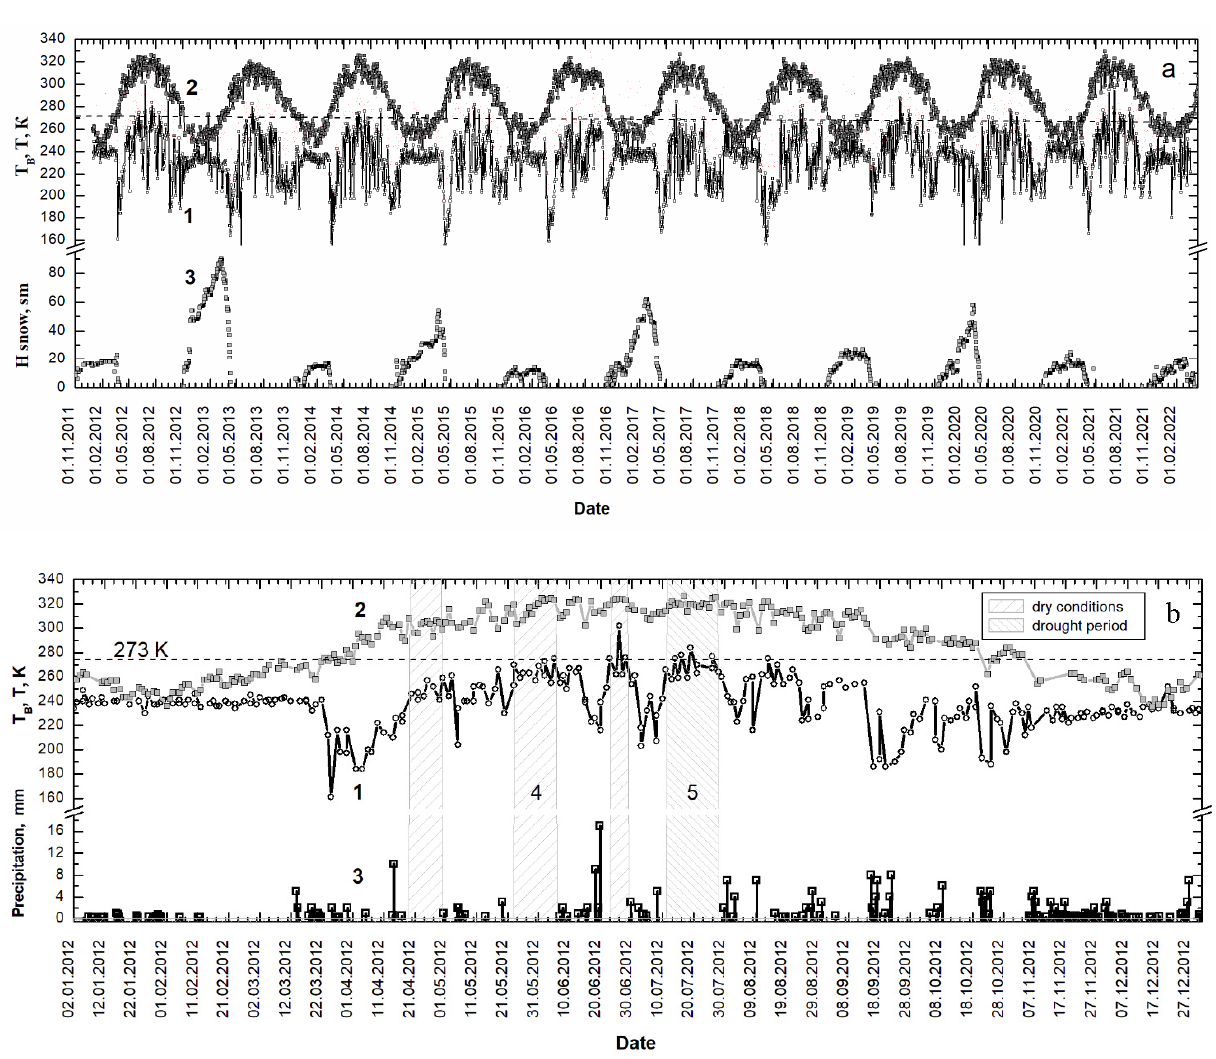
Figure 6. Seasonal dynamics of T BH , T and meteorological parameters: ( a ) snow cover, ( b ) rainfall, ( c ) wind velocity, 1—brightness temperature T BH , 2—temperature T, 3—meteorological parameters (H snow in ( a ), Precipitation in ( b ), and Wind speed in ( c )), 4—periods without precipitation, 5—pe- riod of drought which ended with the declaration of a state of emergency.